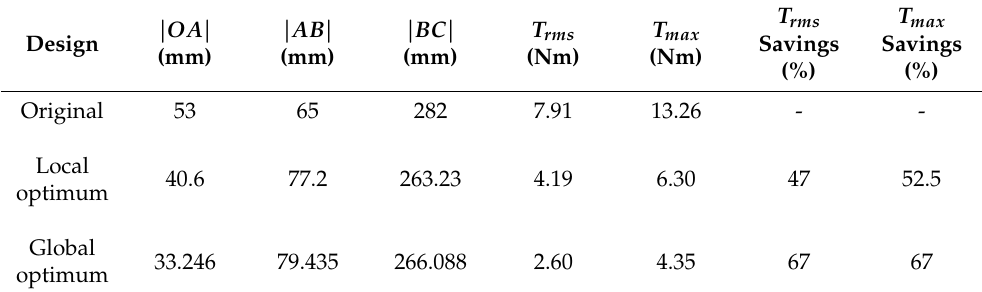
Table 1. Saving potential achieved with design